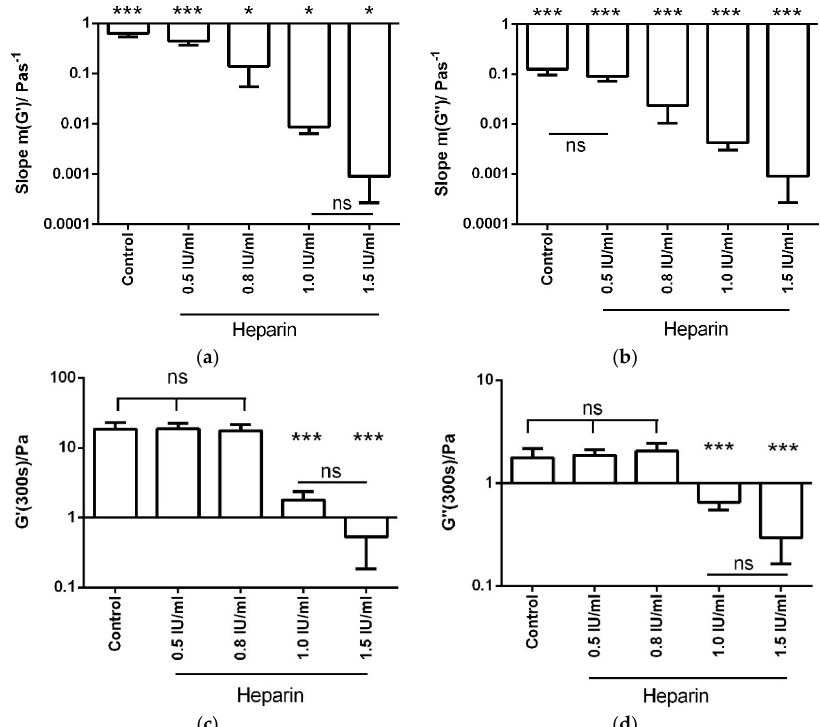
Figure A4. Analysis of linear slopes of elastic ( a ) and viscous ( b ) shear moduli and the elastic ( c ) and viscous ( d ) shear moduli at 300 s in Kinexus Pro measurement of citrated blood with additional heparin activated with Thromborel. The linear slopes of the elastic shear moduli ( a ) were significantly different from each other except 1.0 and 1.5 IU/mL heparin and those of viscous shear moduli ( b ) were significantly different from each other except the control without heparin and the lowest conentration of 0.5 IU/mL. The asterics above the bars indicate that this particular bar is significantly different from all others. The shear moduli at 300 s ( c , d ) were indicative of clot firmness. For both elastic ( c ) and viscous ( d ) shear moduli, there was a sharp significant decrease obsesrved for 1.0 and 1.5 IU/mL heparin. The two higher concentrations were not significantly different any longer, which hints towards a “yes-no” answer in clot firmness. * p < 0.05, *** p < 0.001, ns-non